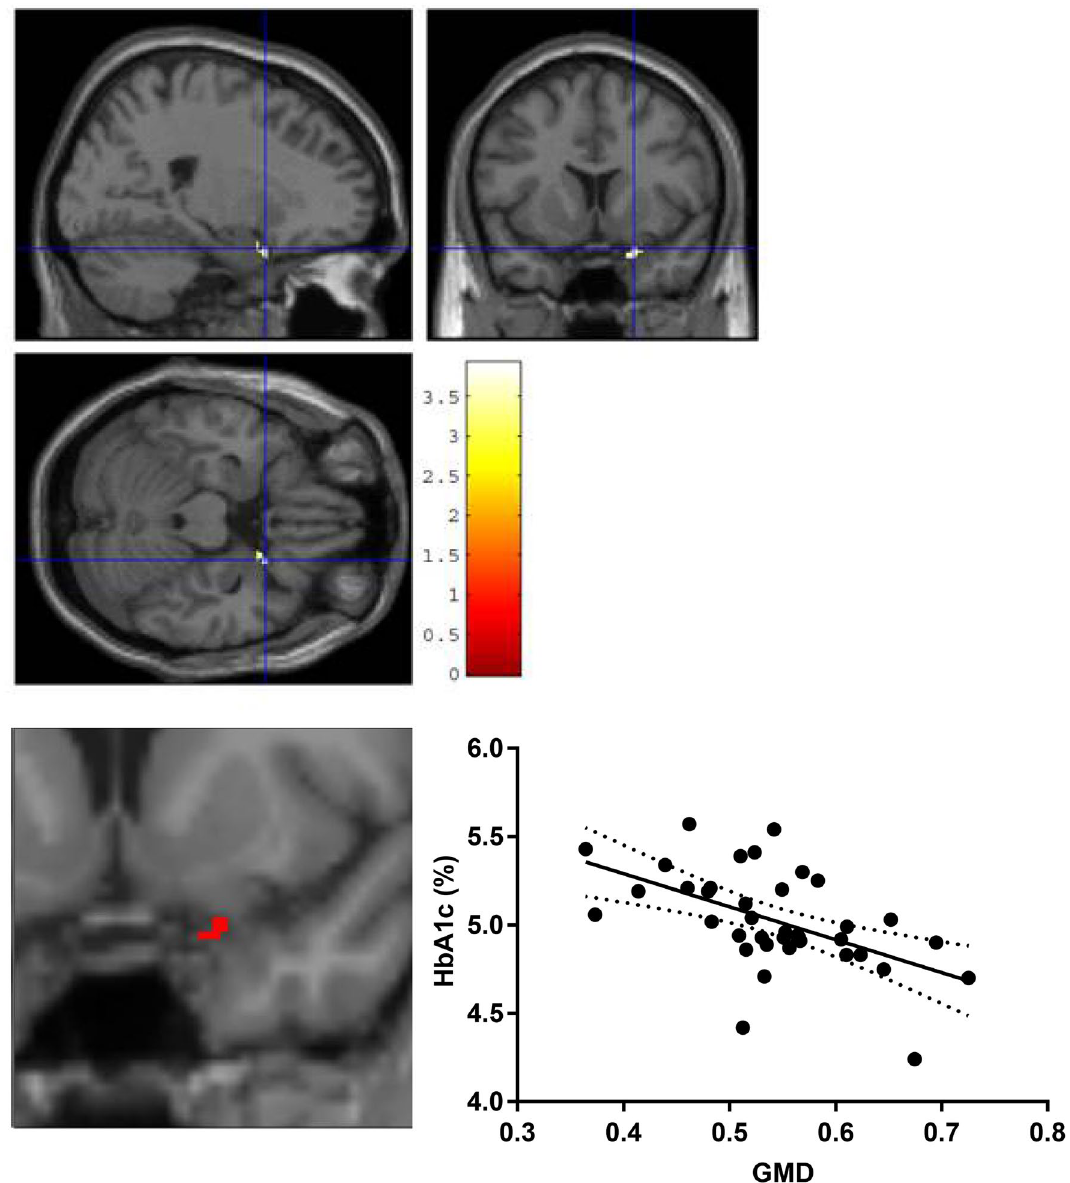
Figure 3. Voxel based morphometry analyses. Correlation between GMD and HbA1c, which showed clusters in parahippocampal region in the right hemisphere (18 voxels, MNI: x = 22.5, y = 11, z = − 22.5 mm, T > 3.91, p <